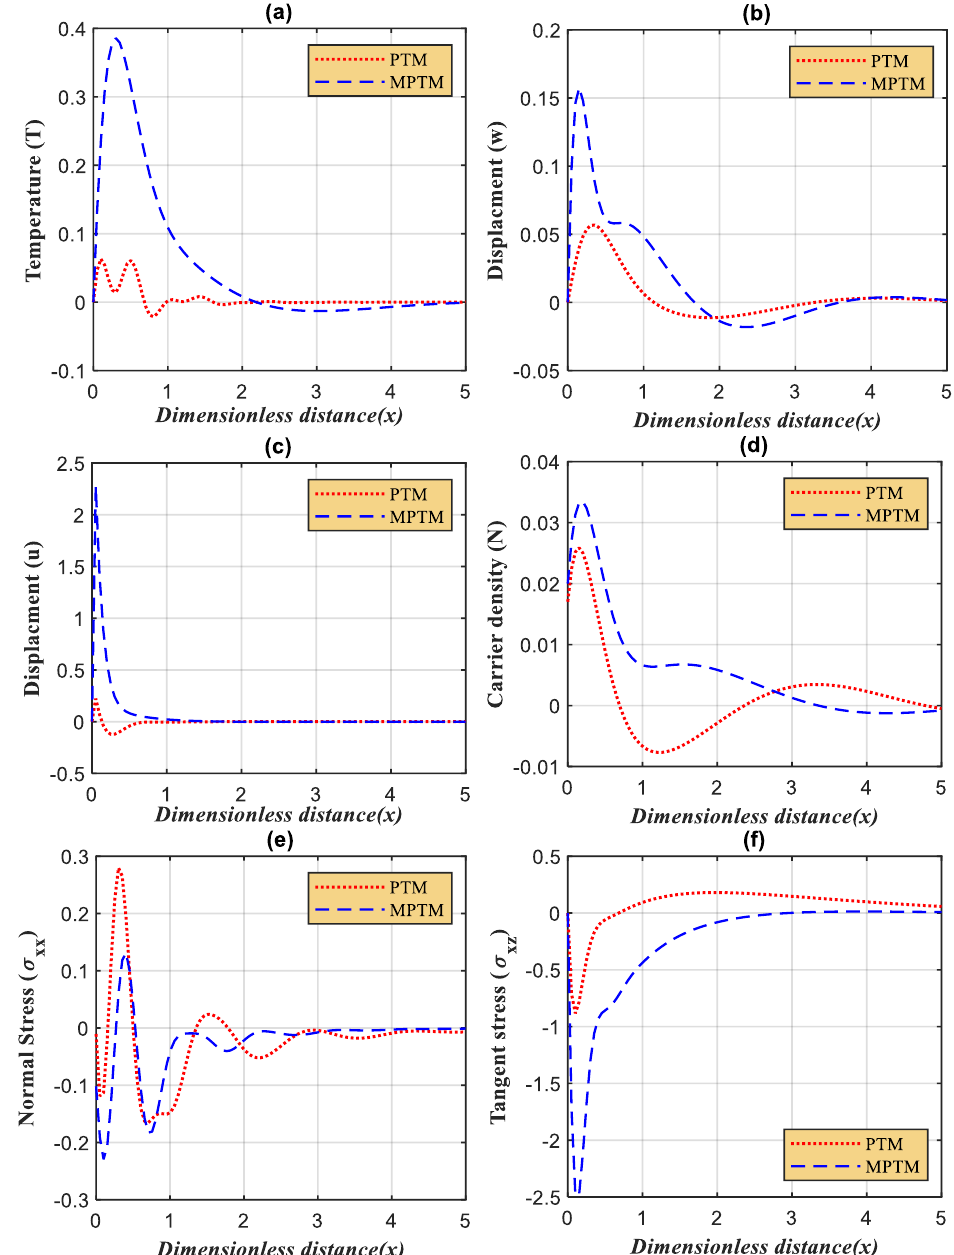
Figure 4. ( a – f ) The variations of the main physical fields versus the horizontal distance according to the GL model with a rotational field under the effect of the microelongation parameters and without the microelongation parameters.